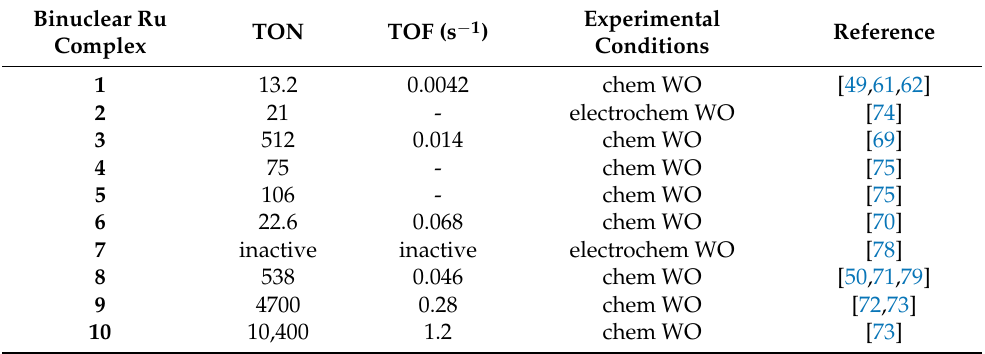
Table 1. Select catalytic parameters and experimental conditions for dinuclear ruthenium catalysts 1–10 , which are active in water oxidation. Electrochemical and chemical water oxidation using CAN are abbreviated as ‘electrochem WO’ and ‘chem WO’, respectively. The TOF values that are not listed in this table are not available in